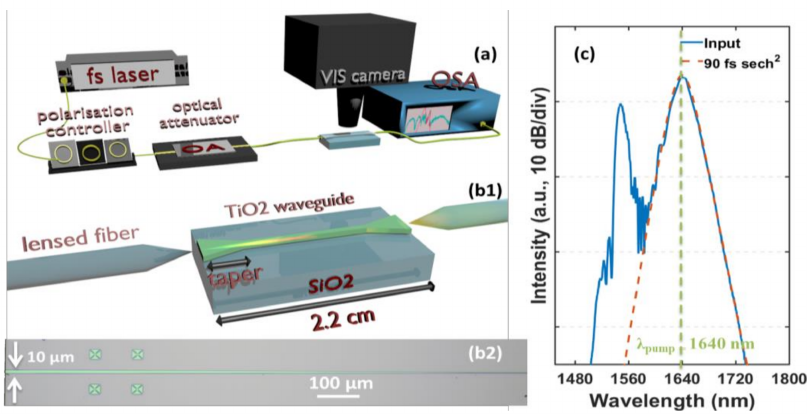
Figure 2. ( a ) Experimental setup involved for generation of supercontinuum in TiO 2 waveguides. ( b1 ) Sketch of the waveguide and butt-coupling thanks to lensed fibres and ( b2 ) the corresponding optical microscope image of the taper used for the coupling. ( c ) Spectrum of the injected soliton pulse centred at 1640 nm compared with the spectrum of a 90 fs sech 2 pulse ( c